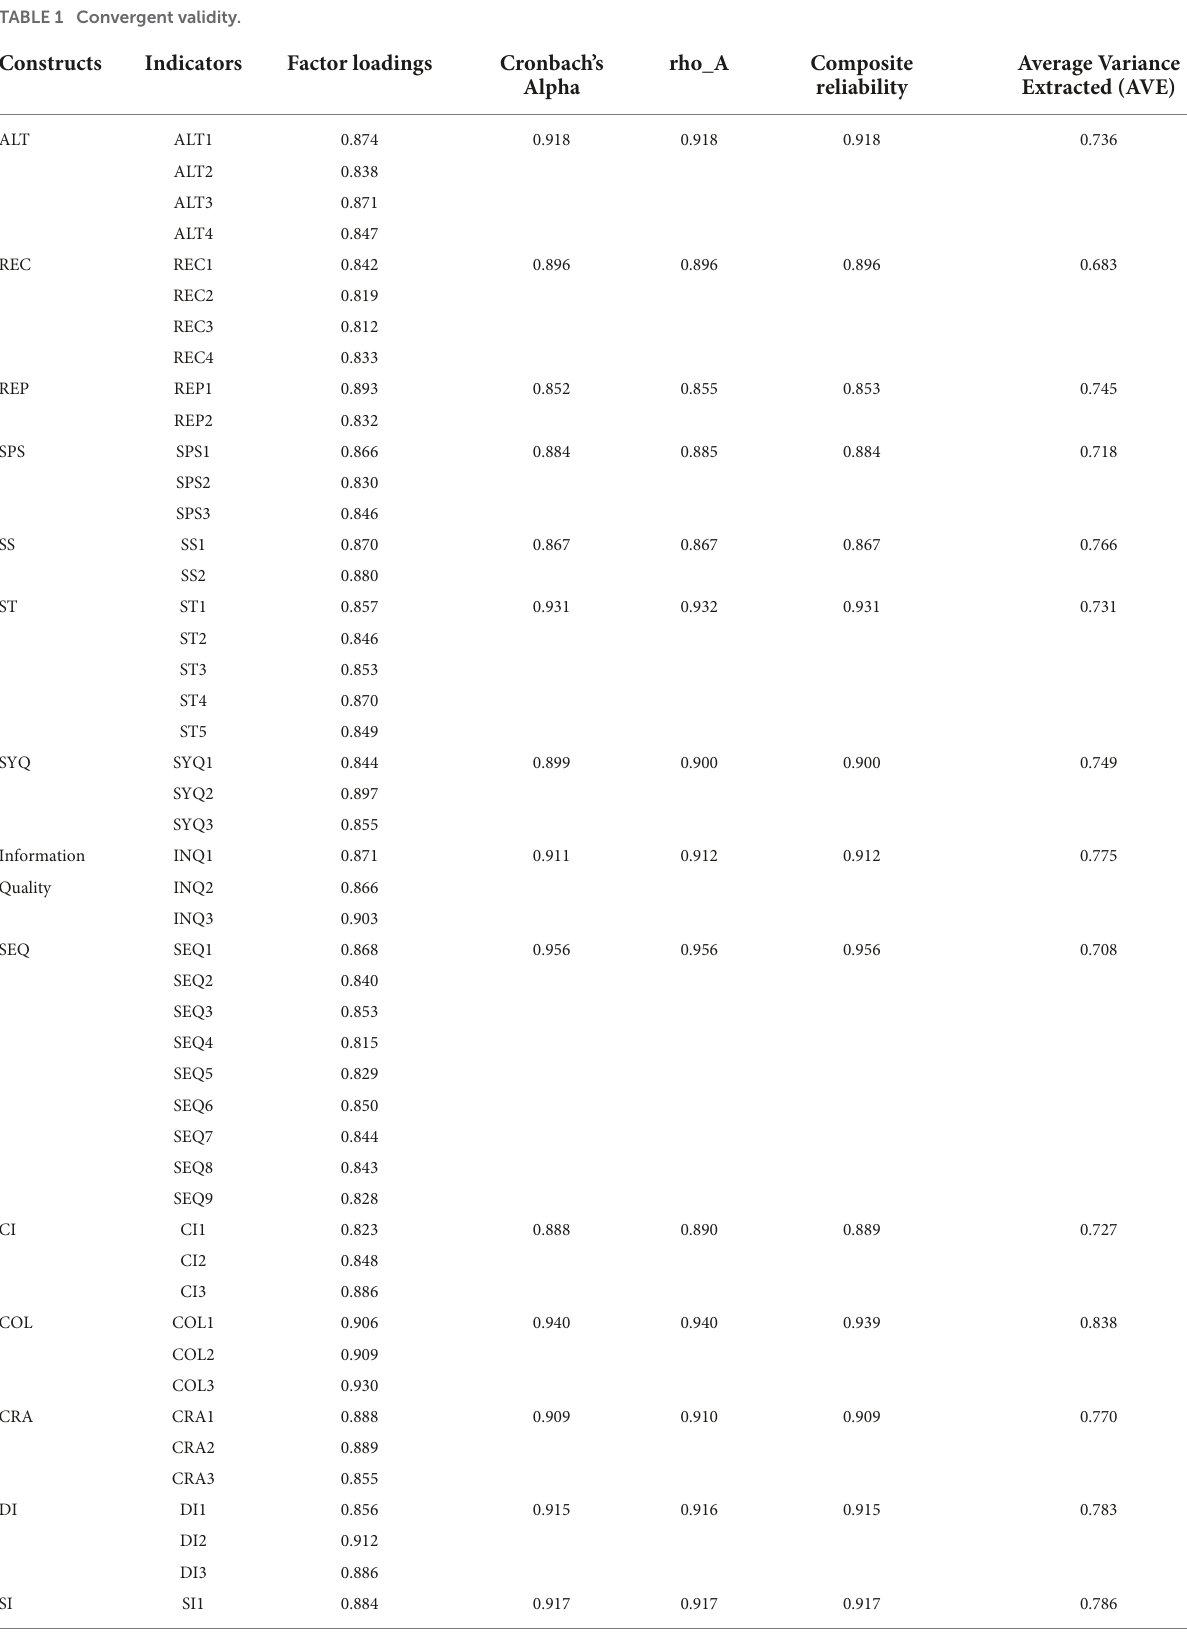
TABLE 1 Convergent